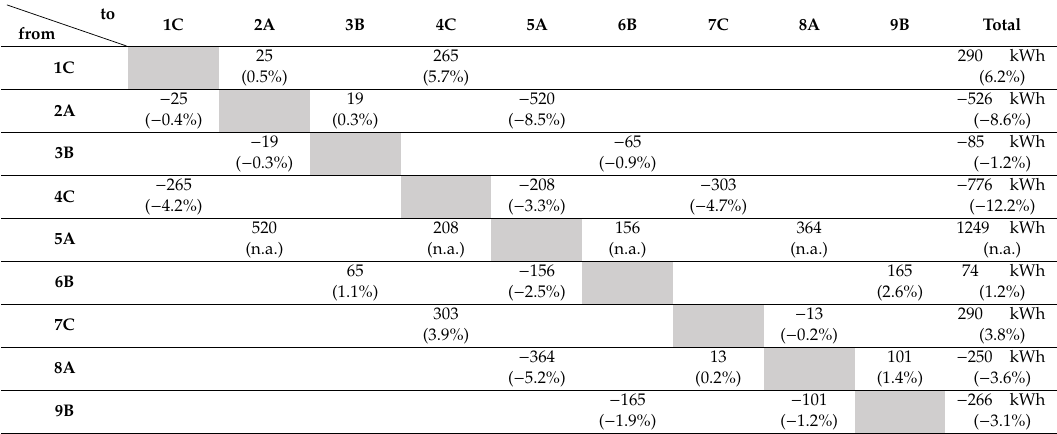
Table 6. Percentage * of heat given or stolen between adjacent apartments, scenario a, kWh and (%). from